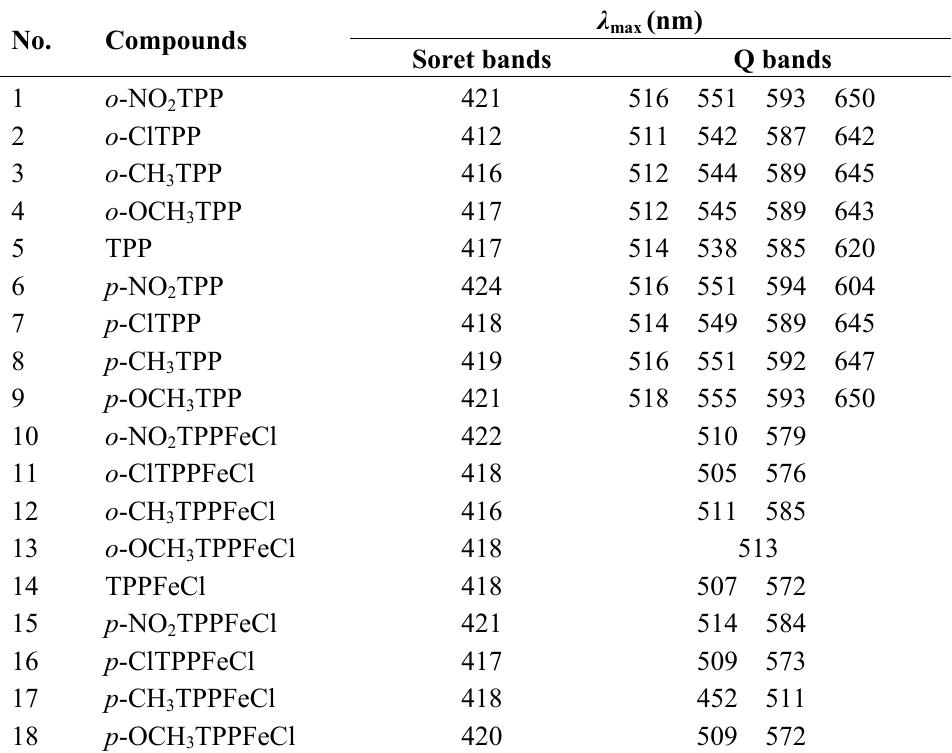
Table 2. UV-vis data of free base porphyrins and substituted tetraphenylporphyrin iron